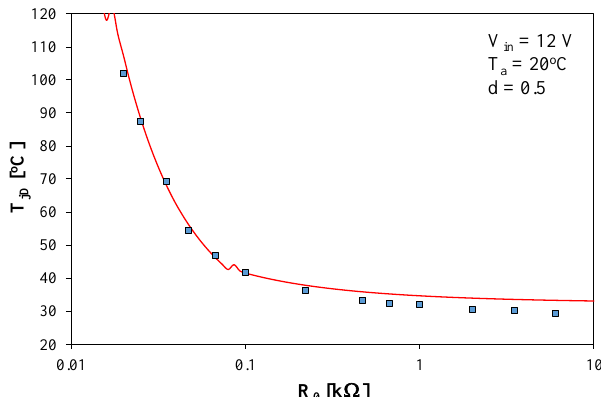
Figure 11. Computed and measured dependence of internal temperature of the diode on load resistance. Energies 2020 , 13 , x FOR PEER REVIEW